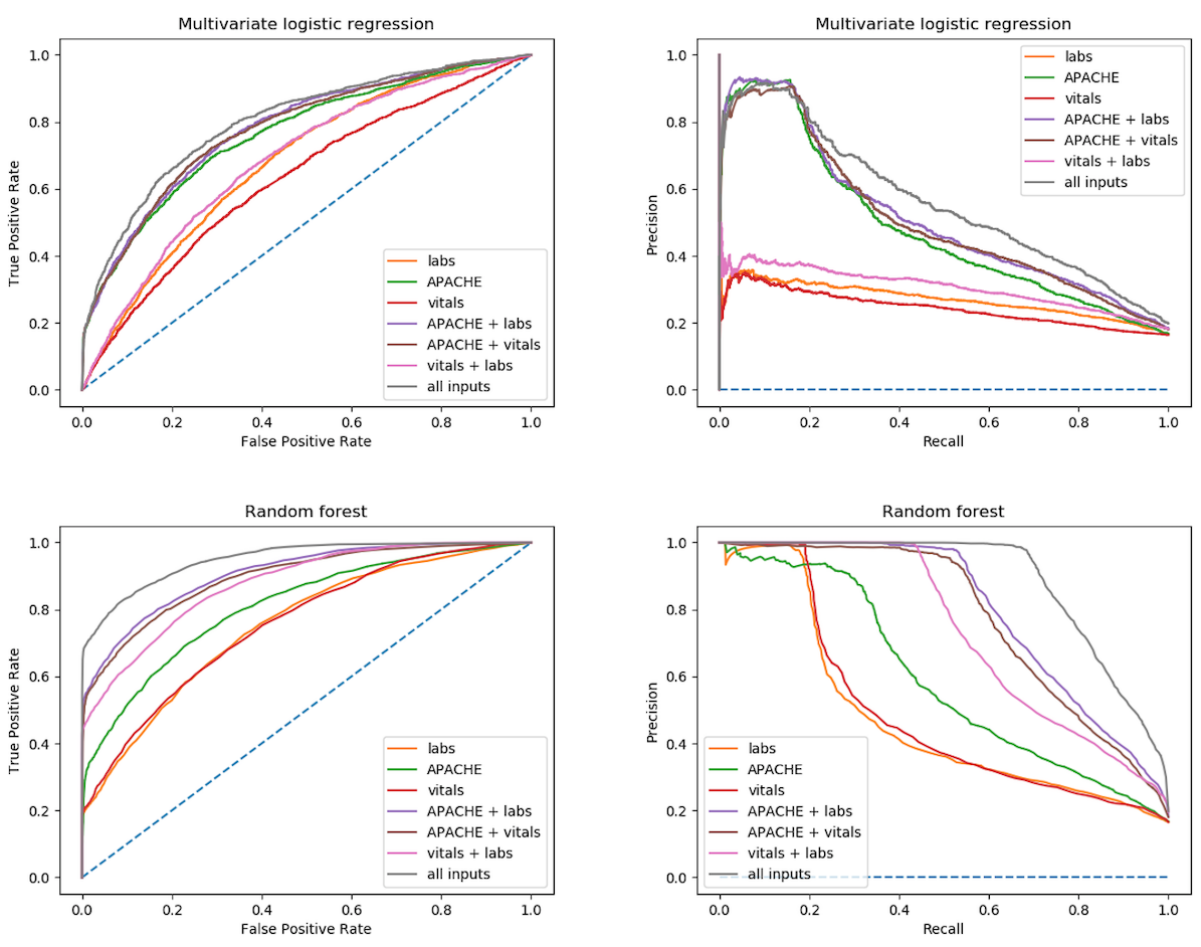
Figure 3. Risk factor patients (patients presenting to the intensive care unit with coronary artery disease, hypertension, or myocardial infarction) area under receiver operating characteristic curve and precision-recall curve for both multivariate logistic regression and random forest models. Each curve represents a different model input combination. The vital signs data extraction window was held constant at 360 minutes for all inputs. APACHE: Acute Physiology and Chronic Health